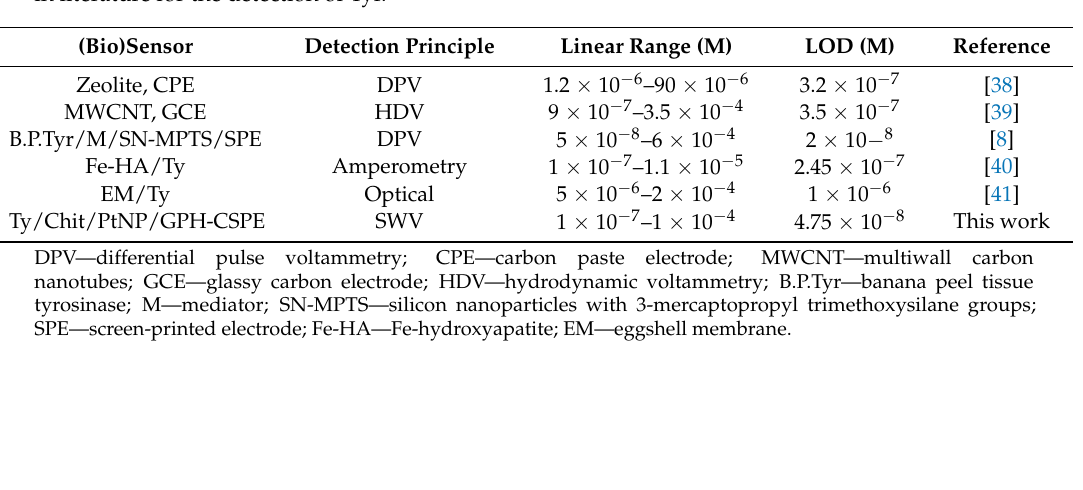
Table 1. Comparison between the Ty/PtNP/GPH/Chit-CSPE biosensor and other (bio)sensors reported in literature for the detection of